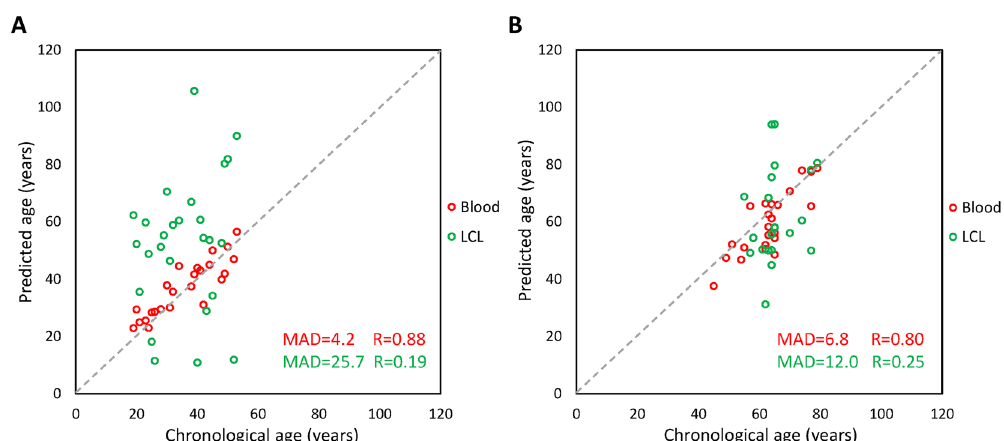
Figure 4. Age predictions of all DNA samples from the DNA methylation-based age prediction model of Thong 44 using three CpG loci and pyrosequencing. ( A ) Age predictions from EFS blood (n = 24) and CEPH families EBV cell line (n = 26) DNA samples. ( B ) Age predictions from blood (n = 24) and EBV cell line (n = 21) DNA samples of the CEPH Aging cohort. The mean absolute deviation (MAD) of the predicted age from the chronological age and the Pearson R coefficient are given on each graph in red and green for blood and LCL samples,